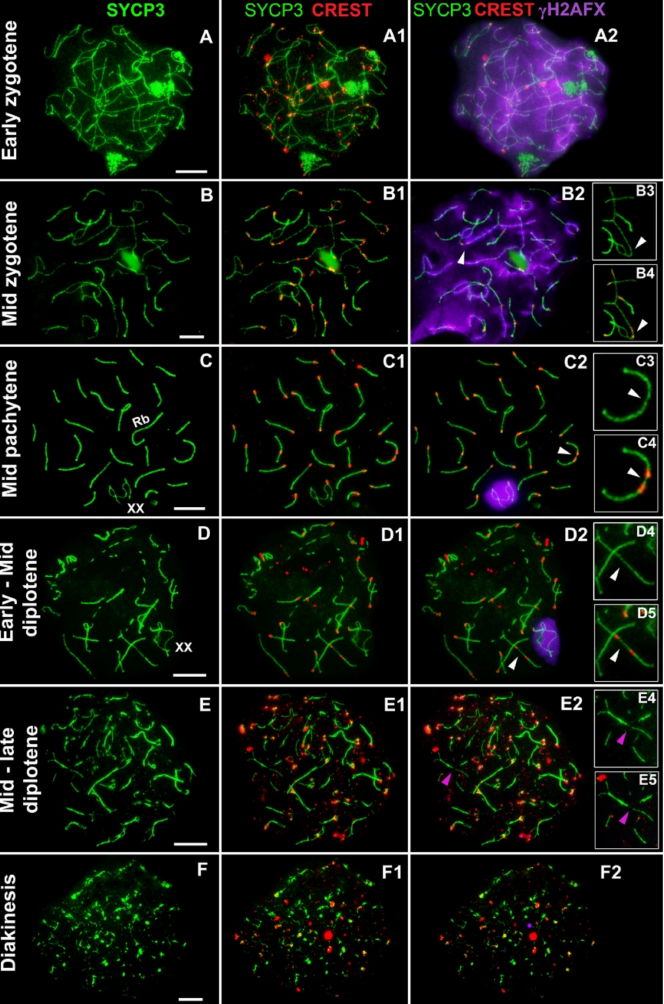
Figure 1. Meiotic prophase I in studied E. alaicus specimens. Axial and lateral elements of the SC were identified using an anti-SYCP3 antibody (green), kinetochores were detected by an anti-CREST antibody (red), and chromatin inactivation was revealed using an anti- γ H2AFX antibody (violet). In early zygotene, axial elements emerge and begin to enter synapsis ( A – A2 ). The entire meiotic nucleus space is filled with the γ H2AFX signal ( A2 ). In mid-zygotene, when almost all homologs begin to synapse, usually (but not always) asynaptic zones of chromosomes are wrapped in a cloud of γ H2AFX ( B – B2 ). The space between chromosomes contains no γ H2AFX signal ( B2 ). At this stage, contacts of nonhomologous chromosomes’ pericentromeric sites are noticeable: one axial element is in contact with the bivalent (arrow, B3 , B4 ). At the mid pachytene stage, all bivalents complete synapsis, and the sex bivalent is displaced to the periphery of the nucleus and capped by a γ H2AFX cloud ( C – C2 ). Meiotic contact of nonhomologous chromosomes is present in this cell: the two bivalents are connected through the SYCP3 bridge that has formed between the two centromeric regions (arrow, C2 – C4 ). In diplotene, SC fragmentation ( D – D2 ) and homolog desynapsis ( E – E2 ) are observed. Meiotic contacts are still visible in early–mid diplotene ( D4 , D5 ), whereas in late diplotene, SYCP3 bridges and SYCP3 contacts are not detectable (magenta arrowhead) because the SYCP3 protein is eliminated from the axis ( E – E2 ). In diakinesis, homologs desynapse and SYCP3, as a clump, is typically visible around the centromeres ( F – F2 ). Scale bar = 5 µ